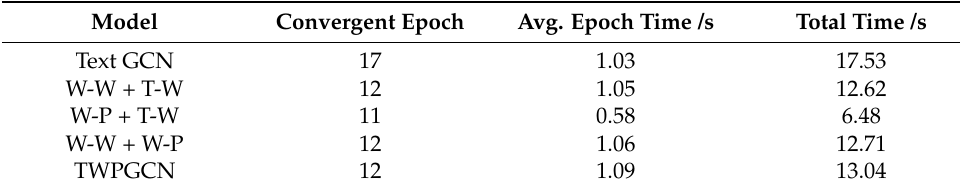
Table 4. Efficiency comparison